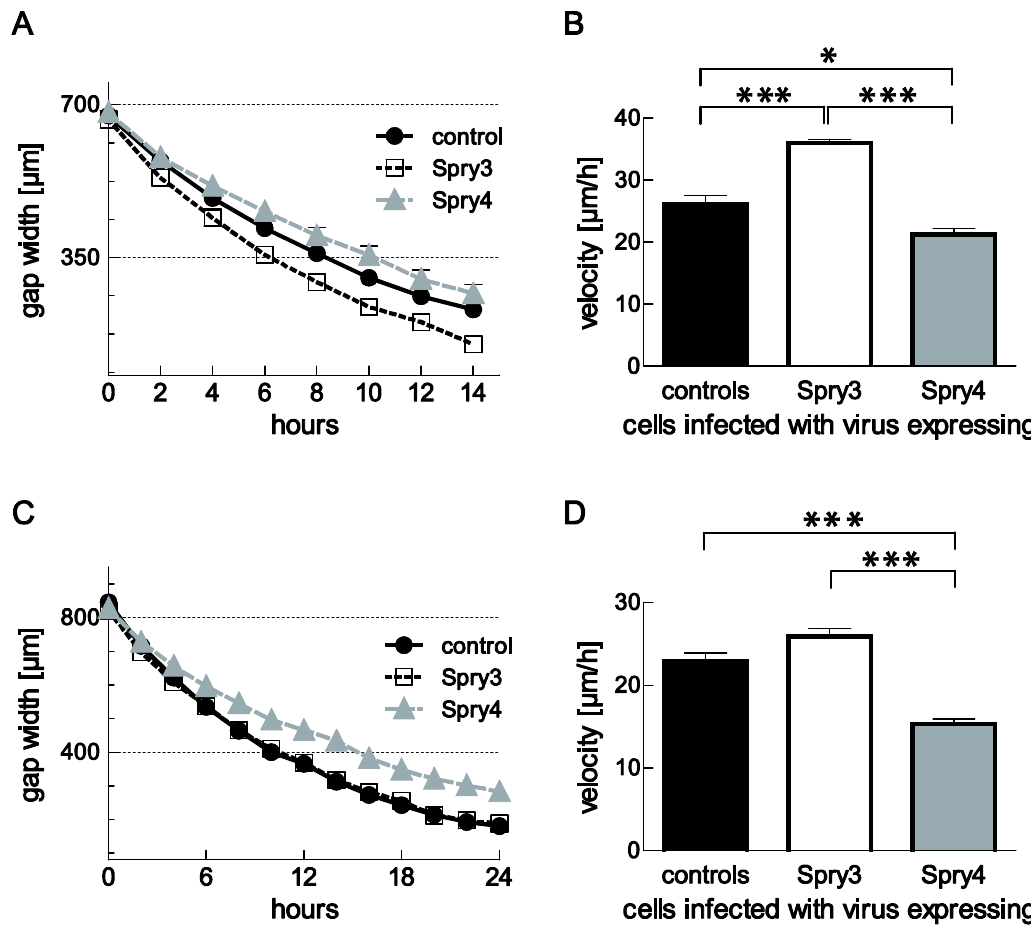
Figure 5. Influence of Spry3 and Spry4 expression on cell migration of GBM-derived cell lines. ( A ) Scratch assay was performed in DBTRG-05MG cells infected with adenoviruses expressing the indicated proteins. Representative curves of distance coverage were obtained by measuring decreasing gap widths of three replicative scratches at every two-hour time points using ImageJ. ( B ) Using linear regression, migration velocities were calculated. Means of at least three experimentations ± SEM are summarized as column bars. ( C ) Representative measurements of replicative gap closure in a close layer of U-373 MG cell expressing the indicated proteins are shown. ( D ) Velocities of at least three experiments were calculated using linear regression in GraphPad Prism and summarized in a graph depicting means ± SEM. An unpaired t-test was used to acquire significance. p < 0.05; ** p < 0.01; *** p < 0.001.